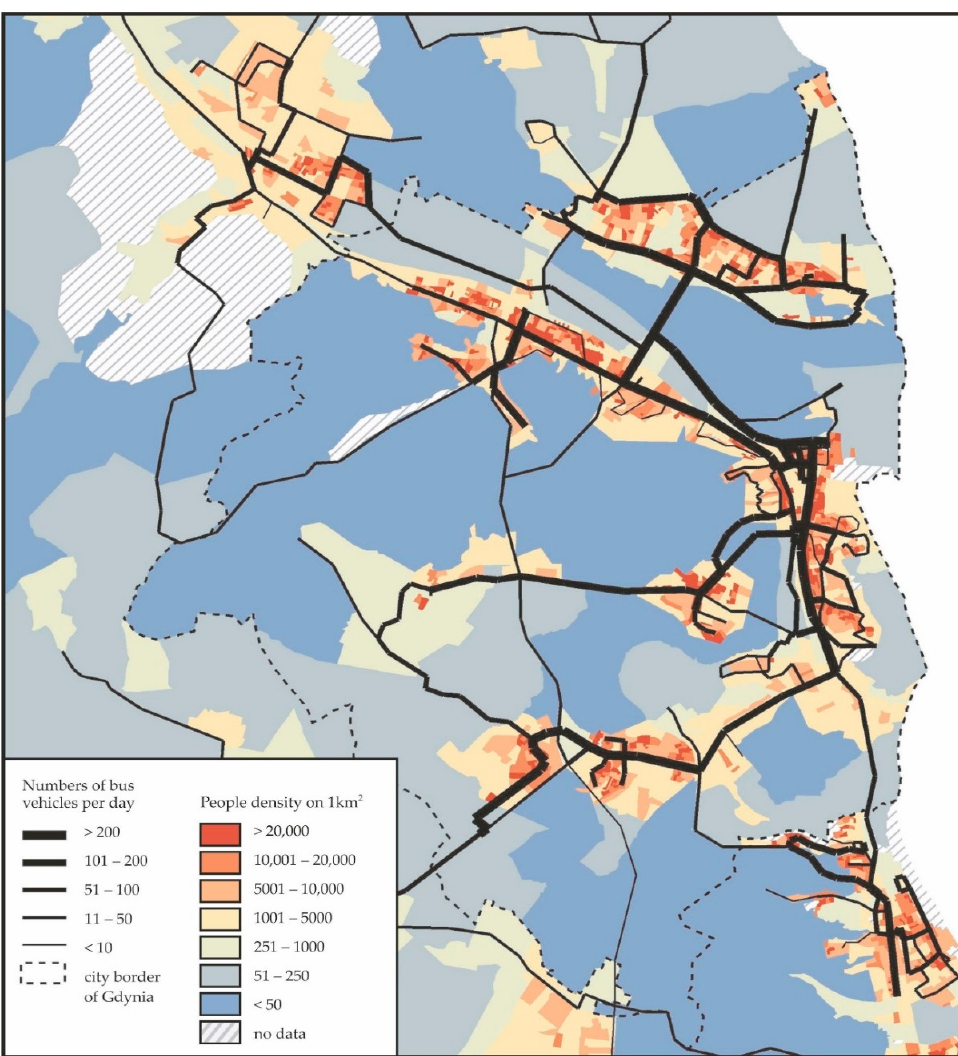
Figure 8. The traffic intensity of bus lines compared to the population density (source: own elaboration).